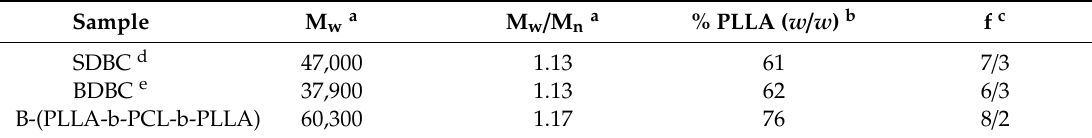
Figure 10. SEC traces monitoring the synthesis of SDBC. Table 3. Molecular characteristics of the statistical and block copolymeric brushes along with the triblock copolymer brush via Ring Opening Metathesis Polymerization of the single macromonomers.